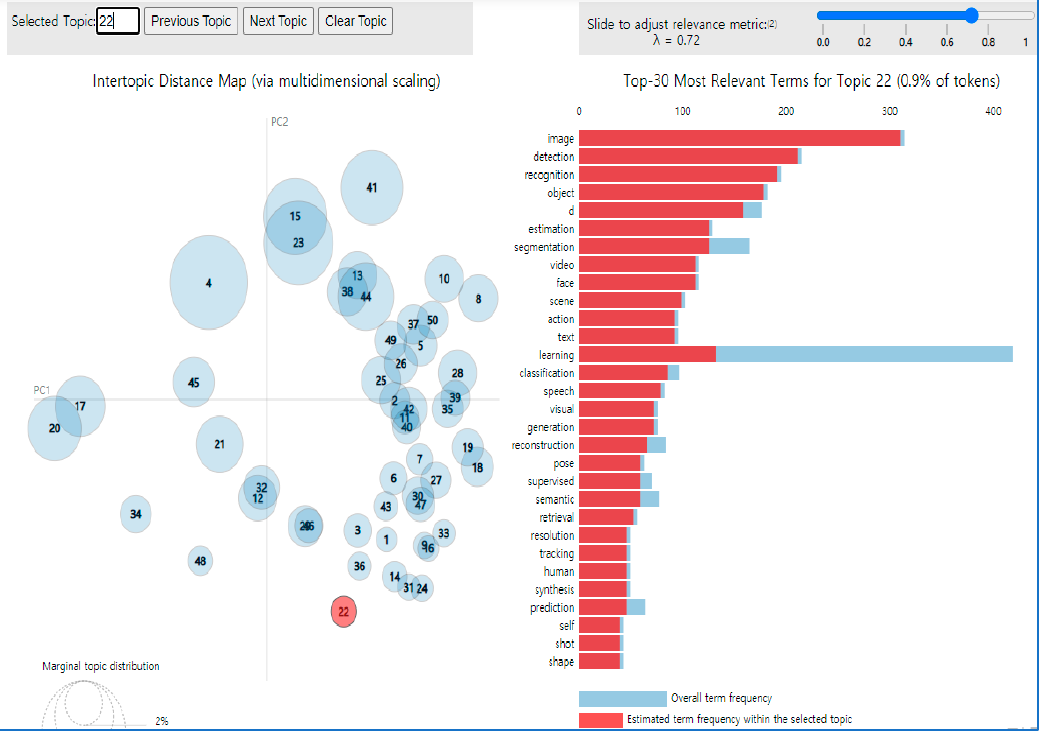
Figure 4. Topic modeling analysis.